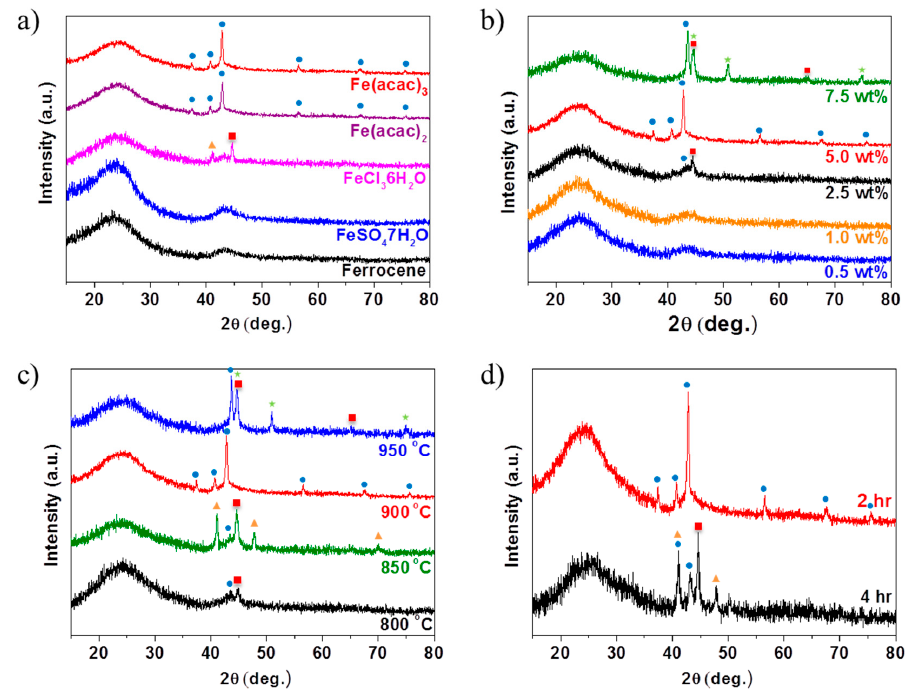
Figure 2. X ‐ ray diffraction (XRD) spectra of Fe ‐ N ‐ C catalysts prepared by altering synthetic conditions. ( a ) Fe source, ( b ) Fe contents, ( c ) pyrolysis temperature, and ( d ) pyrolysis time. The